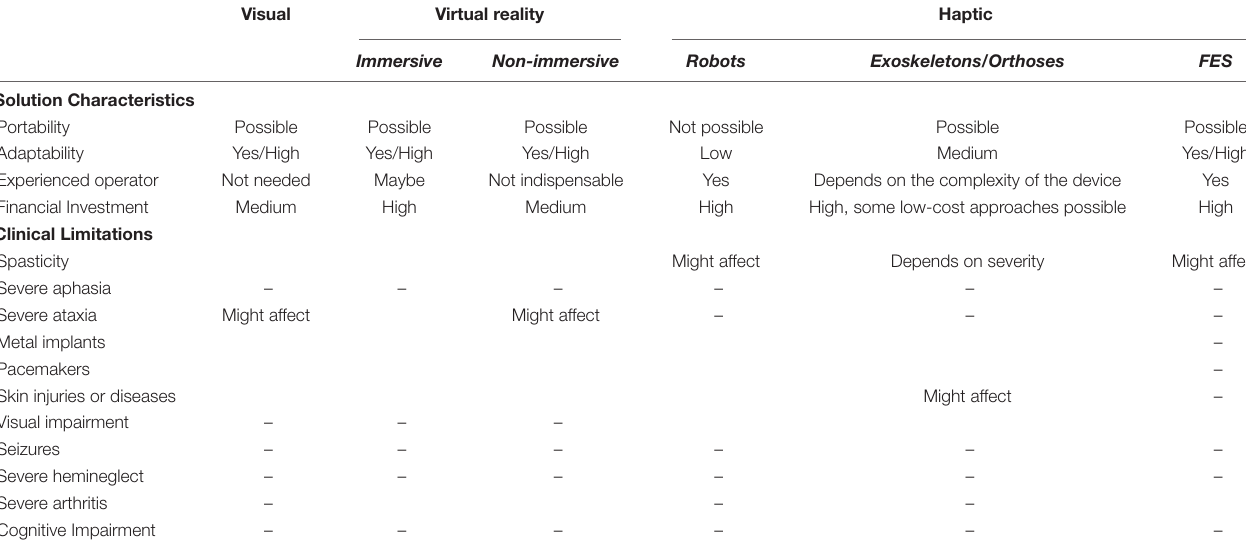
TABLE 3 | Properties to take into consideration while selecting the feedback nature for a post-stroke